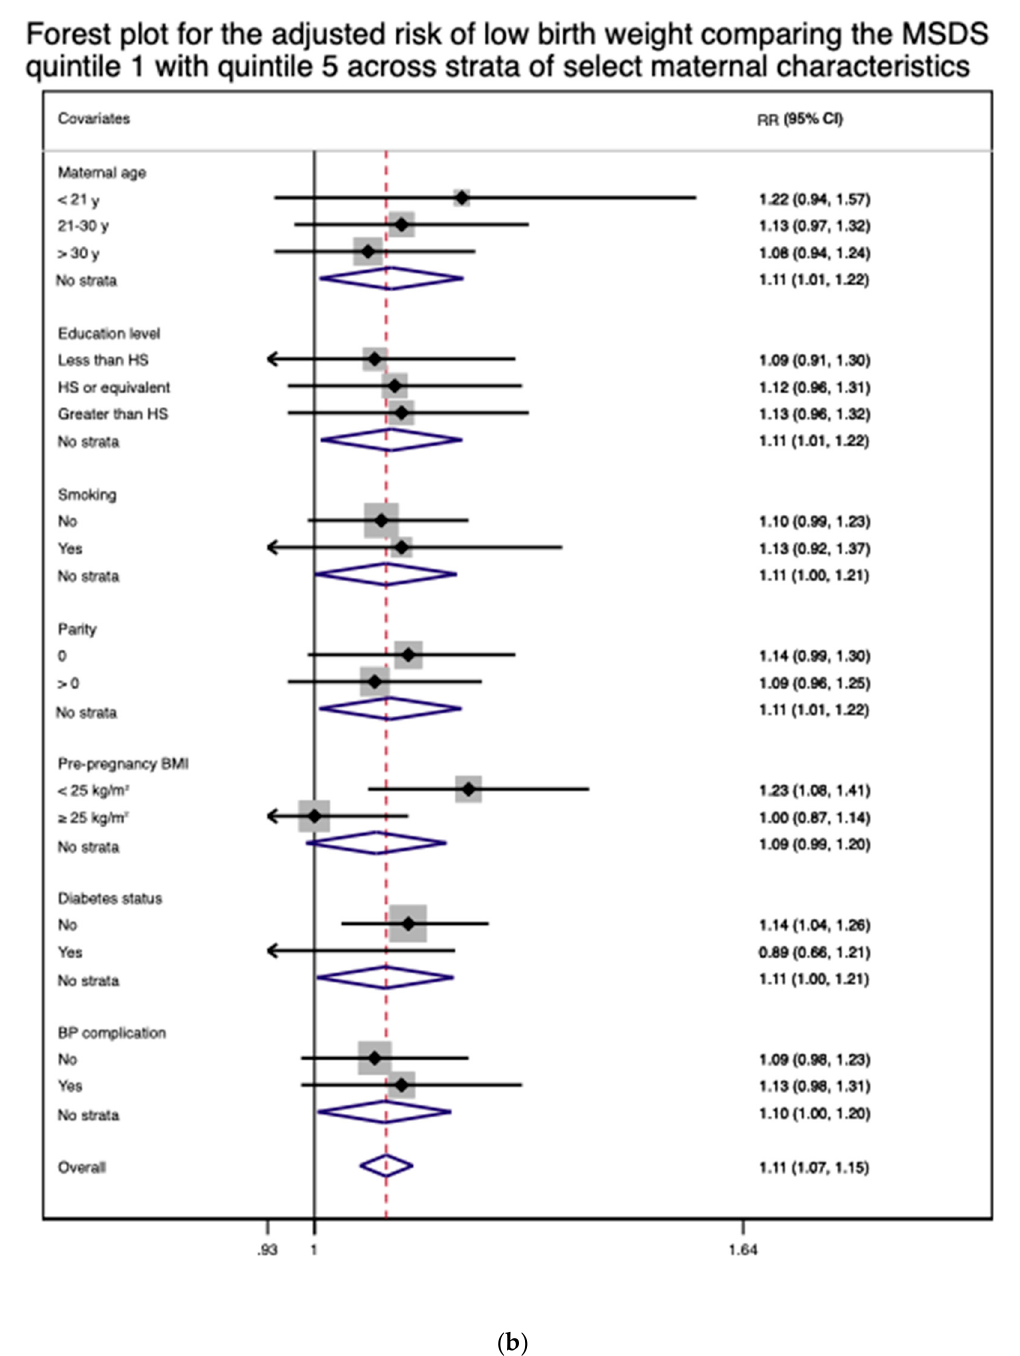
Figure 4. ( a ) A forest plot for the adjusted relative risk (RR) of spontaneous preterm birth comparing the first MSDS quintile with the fifth quintile across the strata of select maternal characteristics. The results were adjusted for all applicable covariates except for child sex. ( b ) A forest plot for the adjusted relative risk (RR) of low birth weight comparing the first MSDS quintile with the fifth quintile across the strata of select maternal characteristics. The results were adjusted for all applicable covariates except for child sex.